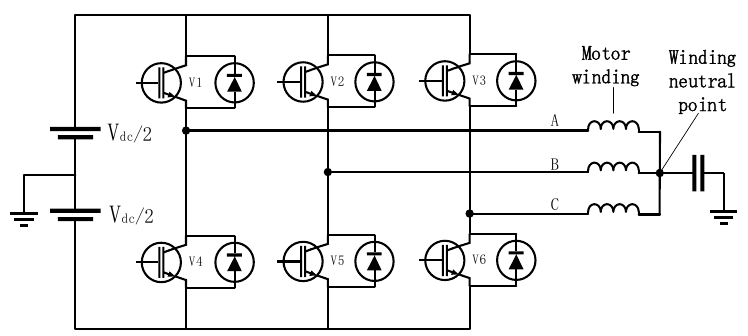
Figure 10. Motor and driver connection circuit diagram.